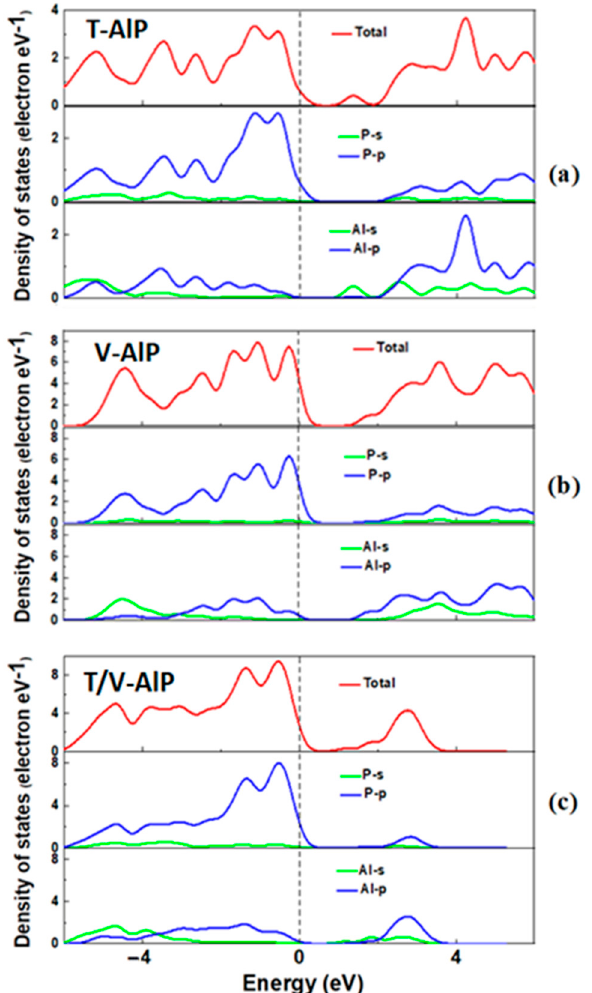
Figure 4. The PDOS of ( a ) T-AlP, ( b ) V-AlP and ( c ) T/V-AlP bilayers. The vertical dotted line represents Femi level.